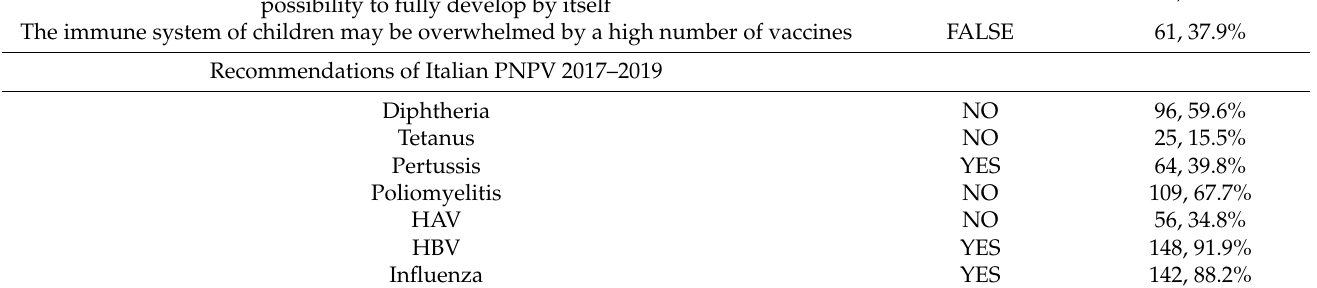
Table 2. Assessment of general knowledge on immunizations, and awareness of specific recommendations (National Immunization Prevention Plan 2017–2019, PNPV 2017–2019) for healthcare workers among 161 first responders participating in the survey (Province of Parma, 2018).